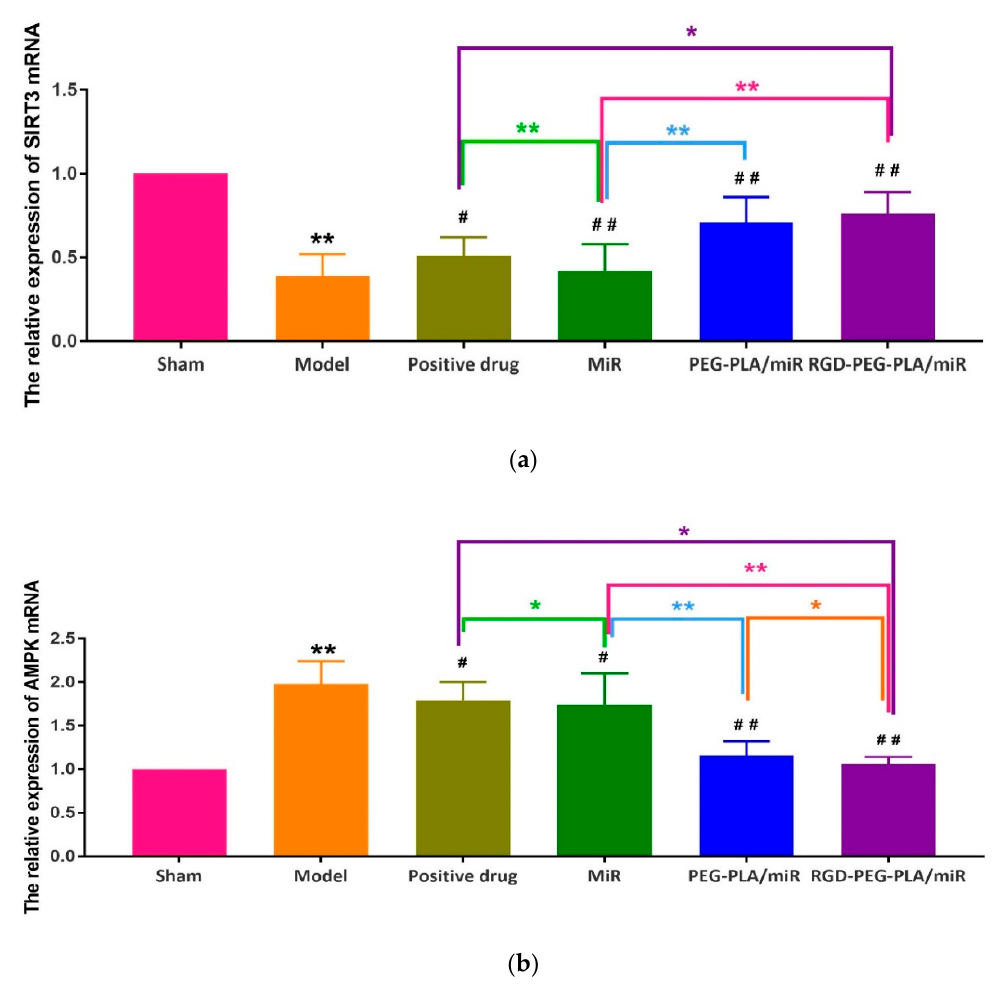
Figure 14. The relative expression of ( a ) Sirtuin3 (SIRT3) mRNA and ( b ) adenosine monophosphate activated protein kinase (AMPK) mRNA in six groups of rats (mean ± SD, n = 6). Compared with the sham group, the difference was statistically significant (** p < 0.01). Compared with the model group, the difference was statistically significant ( # p < 0.05, ## p < 0.01). The color asterisks indicate significant differences between the two groups, * p < 0.05 and ** p < 0.01.